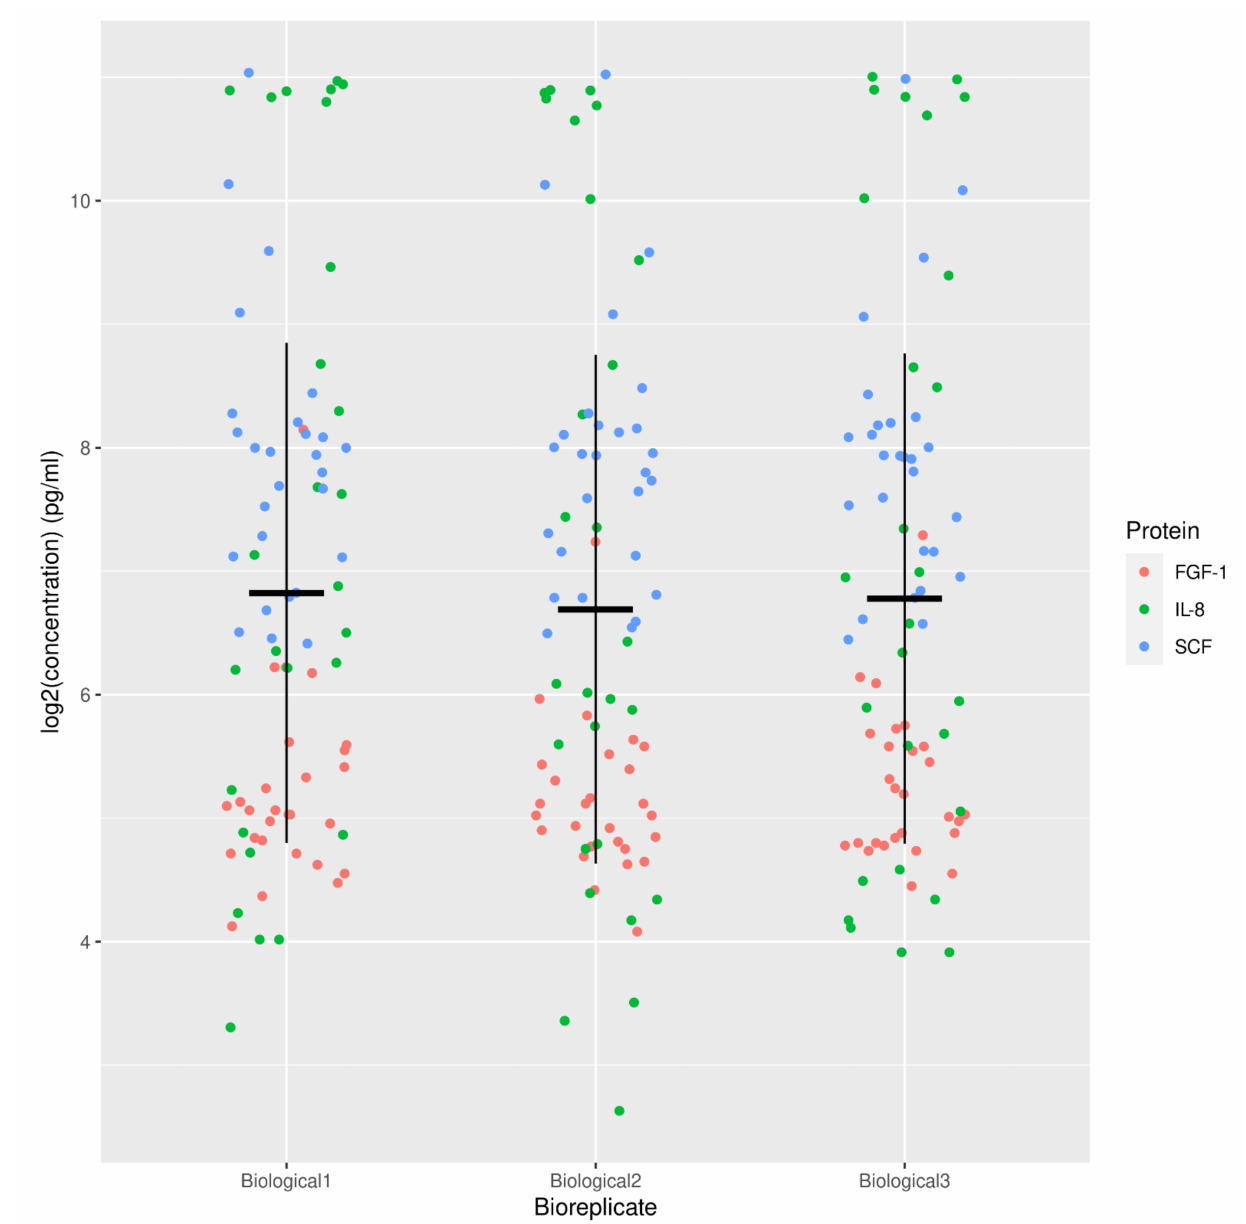
Figure 7. Strip plot of log2 concentration in pg/mL against the different biological replicates for secretion of FGF-1, IL-8, and SCF